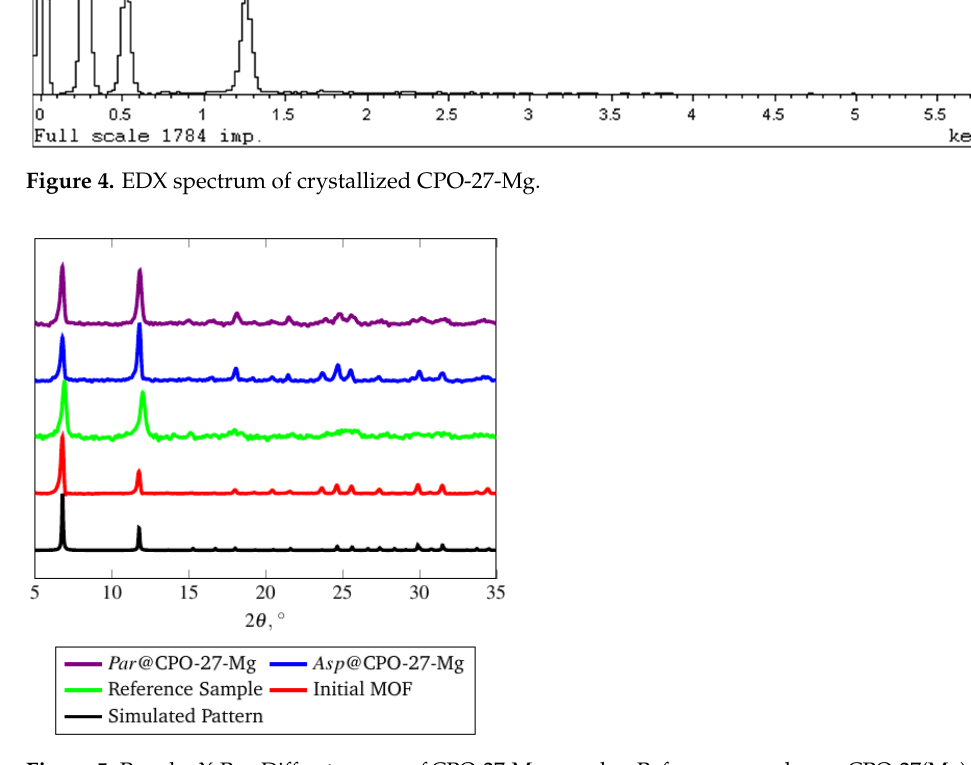
Figure 5. Powder X-Ray Diffractograms of CPO-27-Mg samples. Reference sample was CPO- 27(Mg) prepared by the solvothermal method. Initial MOF was CPO-27(Mg) prepared by the microwave